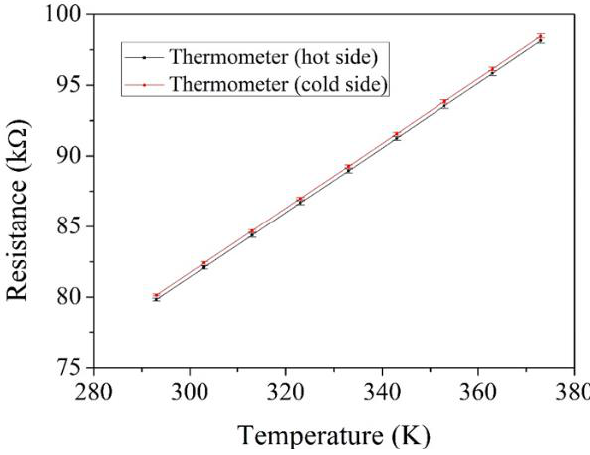
Figure 12. Measured resistance of the thermometers.